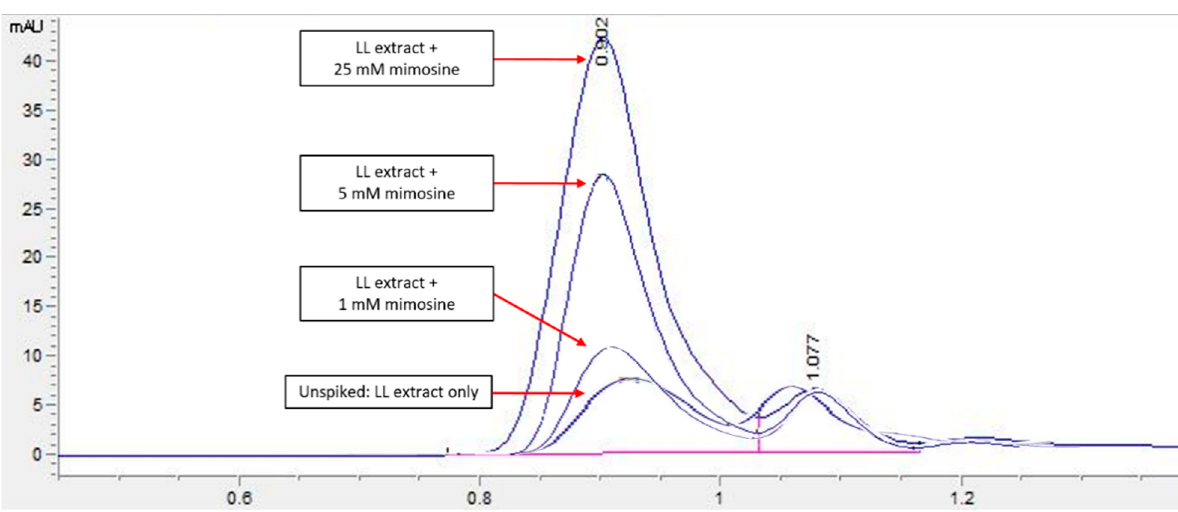
Figure 4. HPLC chromatogram profile for LL extract spiked with mimosine. An increase in the peak heights was apparent for all spiked samples compared to the unspiked LL extract, particularly at an RT of 0.9 min. Key: y -axis: mAU, milli-absorbance unit; x -axis: min, minutes. Table 2. HPLC report for LL extract with and without spiking with mimosine.